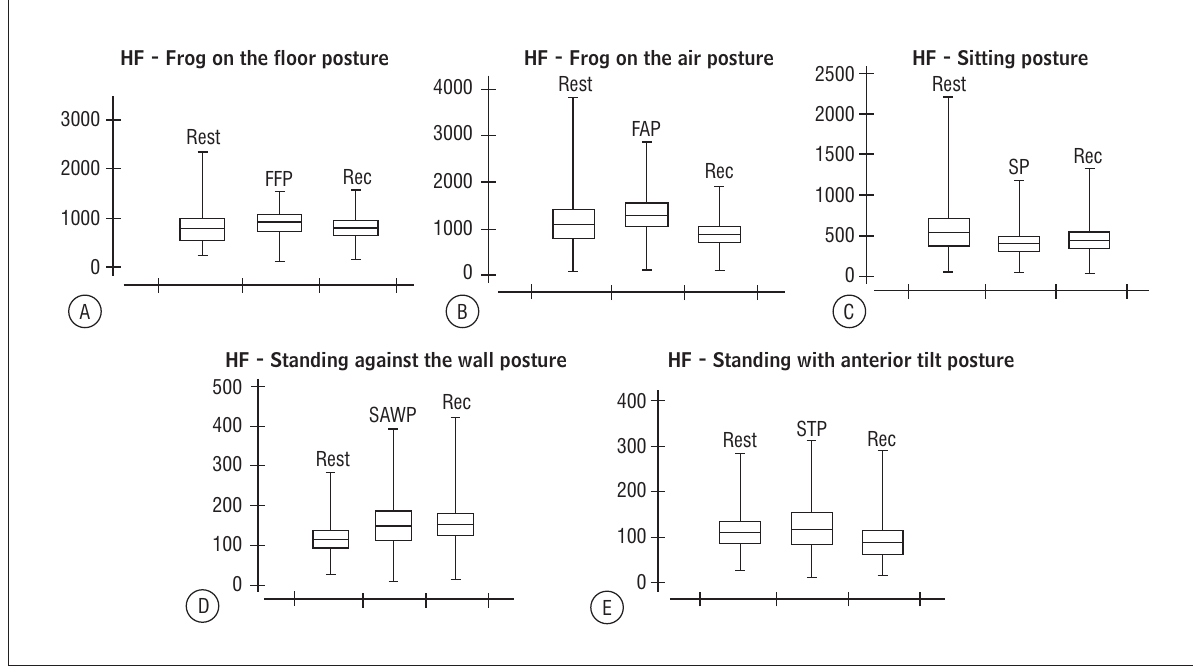
Figure 2 - Boxplot of the mean and standard error of the HF values (parasympathetic area) during the rest, during the pos- tures: A) frog on the floor (FFP), B) frog on the air (FAP), C) sitting (SP), D) standing against the wall (SAWP), and E) standing with anterior tilt (SATP) and the recovery Source: Research